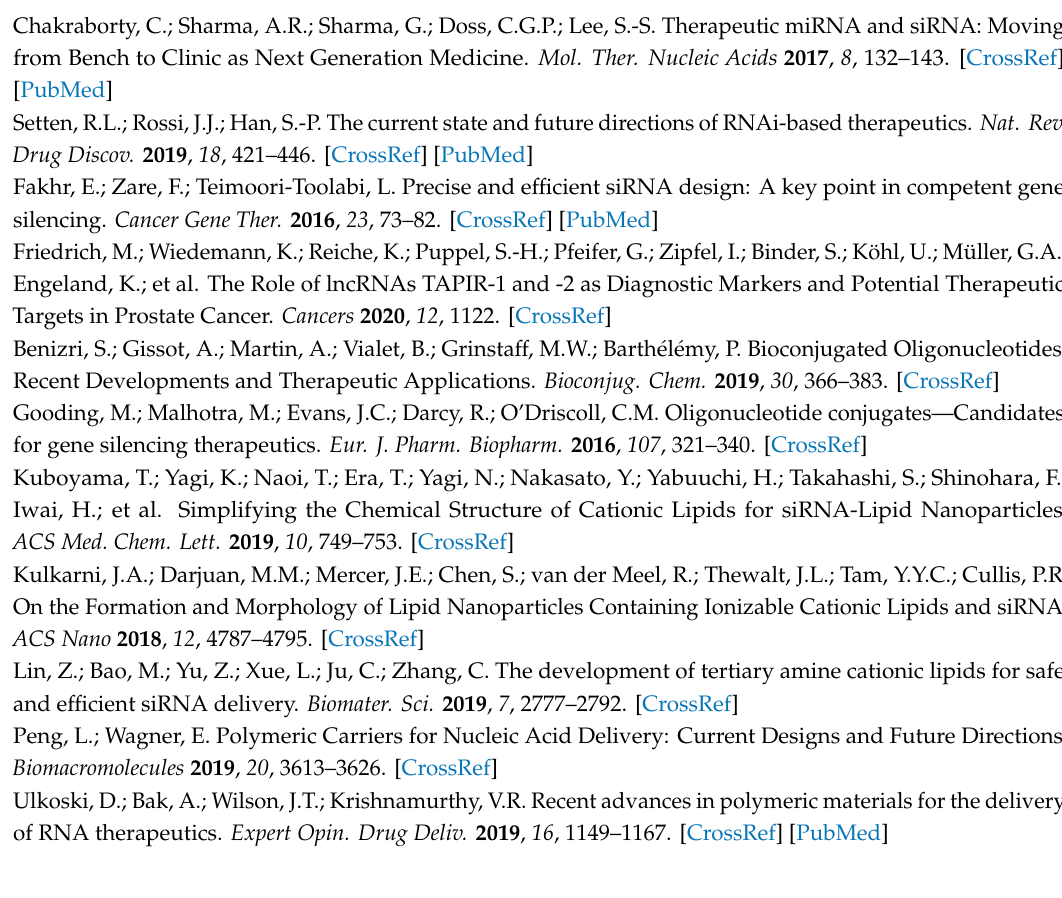
Figure S1: Synthesis scheme and 1H-NMR analysis of PPI-G4-Y. Figure S2: Knockdown e ffi cacies of